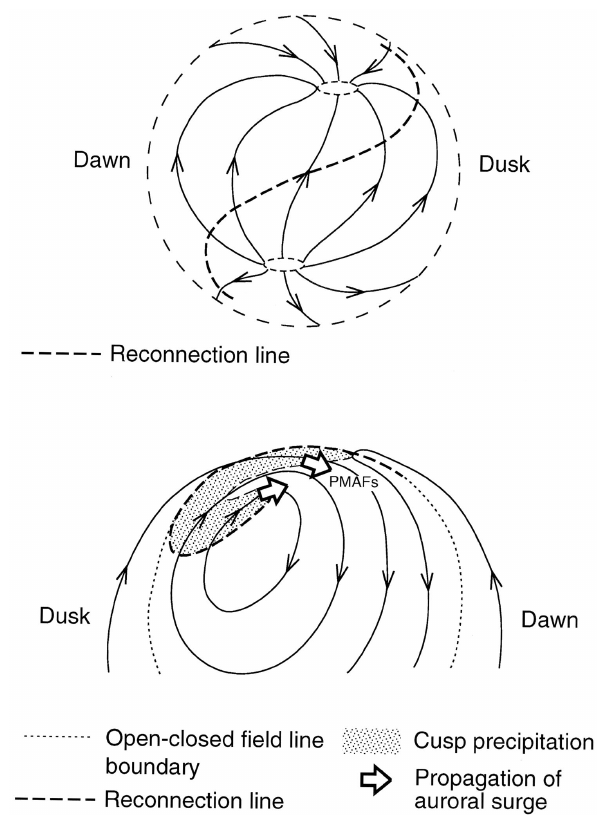
Fig. 16. The upper panel shows a schematical illustration of mag- netic field lines just inside the magnetopause which are tilted over in the direction of IMF B y . Reconnection line is marked by dashed tilted line. North is up and the dawn side is to the left. The lower panel shows the corresponding convection pattern with cusp auro- ral precipitations. 12:00MLT is up and the dusk side is to the left. Open arrows mark the westward expansions of the two components of the bifurcated cusp aurora associated with activations of merging and lobe convection cells. The ionospheric footprint of the merging line is marked by dashed curved line. The dotted line marks the open-closed field line